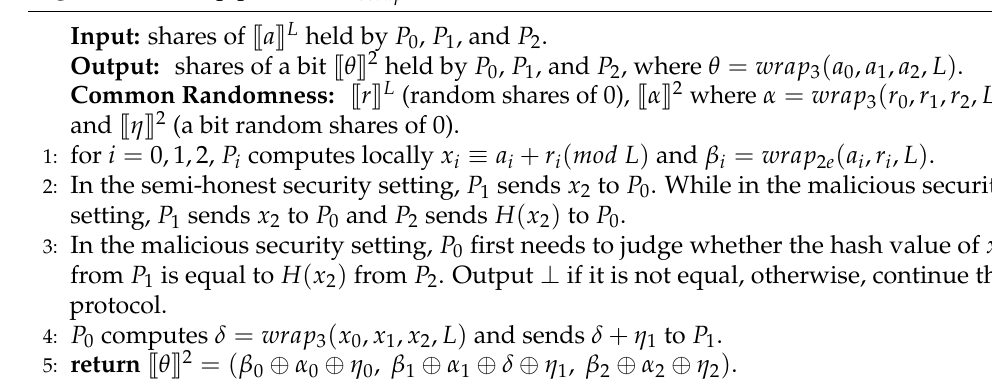
Algorithm 3 Wrap protocol ∏